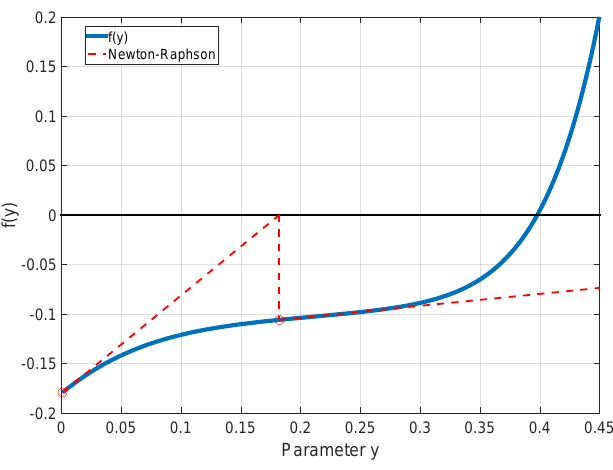
Figure 1. Example of failed solution of the H-Y